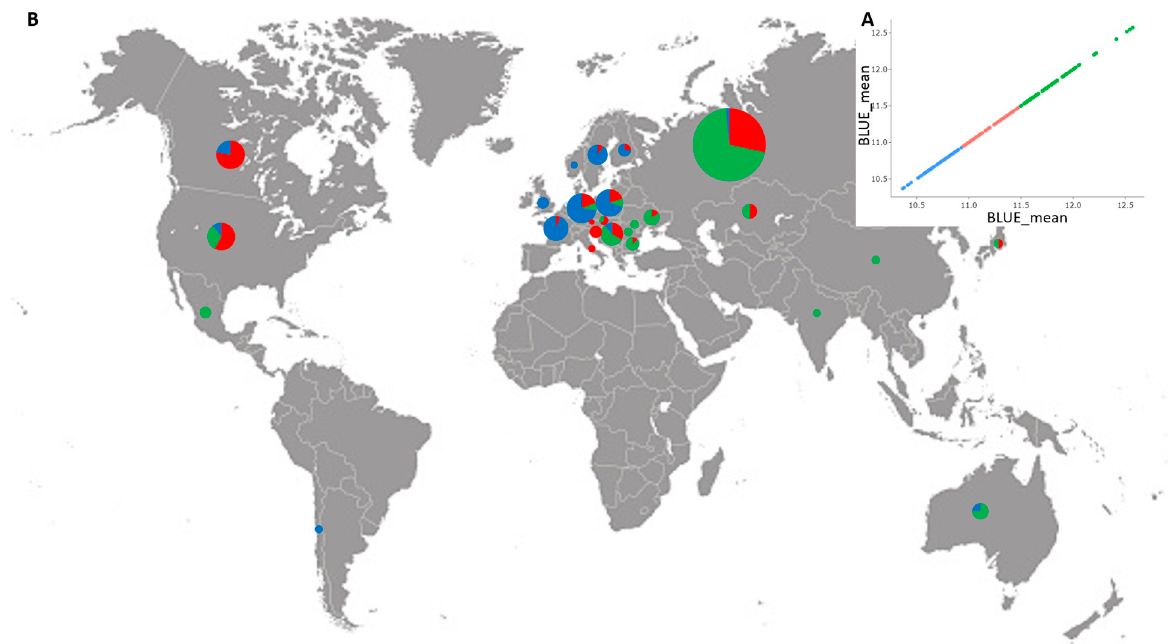
Figure 3. ( A ) Cluster distribution of 255 bread wheat accessions from 27 countries for GPC based on BLUEs averaged over three growing seasons; ( B ) geographic distribution of the wheat accessions. Circles indicate the proportion of accessions with low (blue), medium (red), and high (green) GPC in each country pool.